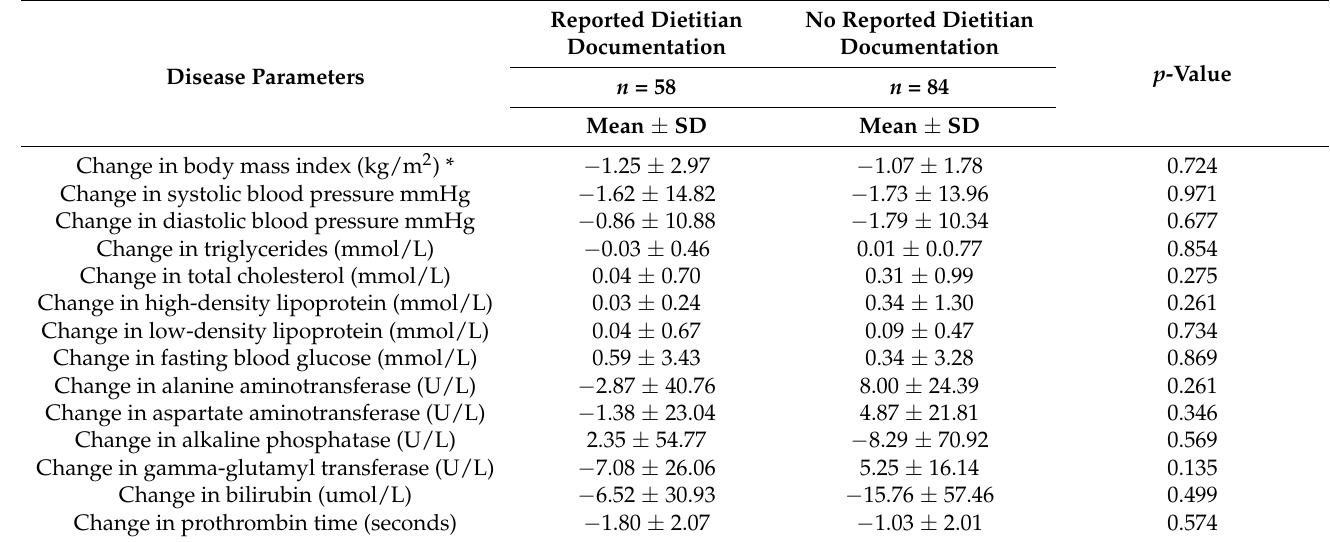
Table 5. The disease parameters in subjects with and without reported dietitian documentation.